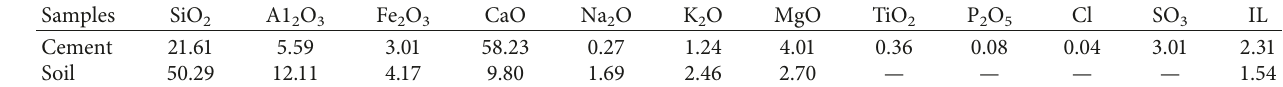
Table 2: Soil and cement chemical composition (content (%)).